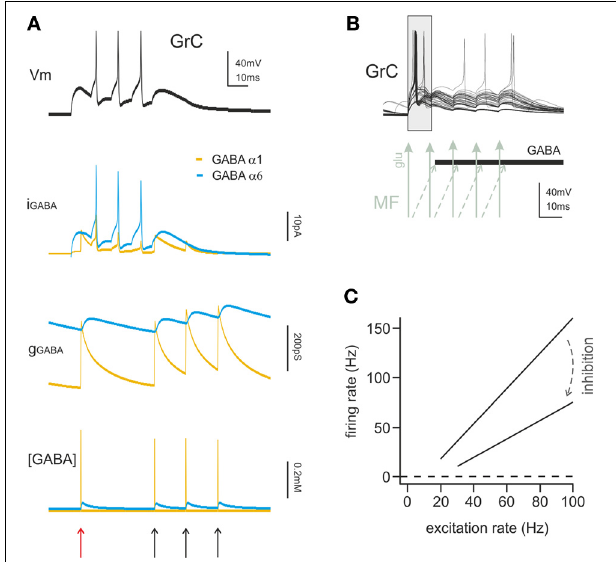
FIGURE 3 | The action mechanisms of phasic and tonic inhibition. (A) Computational simulation of a single GrC placed in a large network model of the cerebellum cortex (15000 GrCs, 450 GoCs considering all GoCs providing input on the simulated GrCs). The GrC is located at the edge of the spot of MF terminals activated by a spike burst (5 spikes at 100Hz), in the area of transition between the center and surround map of the excitatory/inhibitory balance. The stimulus is conveyed to the GrC by 3 of its MF synapses. The same GrC receives inhibitory input from 4 distinct GoCs, one active at the beginning of the stimulation and three activated by feedback at the end of the burst. The GrC membrane potential ( top black trace ) shows the GrC response to the stimulus. The late onset of the first spike caused by the feedforward inhibition ( red arrow ) and the generation of late spikes is prevented by the feedback inhibition ( black arrows ). The other traces provide additional information on the time course of the inhibitory input showing the total GABAergic current and conductance received by the GrC. The slow α 6 component is little modulated by incoming spikes but the spontaneous activity of GoCs (8Hz) ensures the maintenance of a basic level of inhibitory conductance. The lower trace shows the total concentration of GABA present in the synaptic cleft of the 4 inhibitory synapses. (B) Computational simulation of multiple granule cell spiking activity in presence of inhibition, activated through the feedforward mechanisms and generating the time-window effect. This set of GrCs was located in the center of the activated spot (where the excitatory/inhibitory balance favors excitation) and received the spike burst on all 4 of their dendrites. In this configuration the time-window effect dominates the GrC response favoring spikes elicited in the early phase and suppressing spikes in the late phase of the stimulus. (C) linear fit for granule cell I/O relationship in control and with tonic inhibition active ( arrow ), derived from dynamic clamp on acute slices. The change in the slope of the fitting indicates a change in the gain of synaptic transmission at the mf-GrC synapse (modified from Mitchell and Silver,